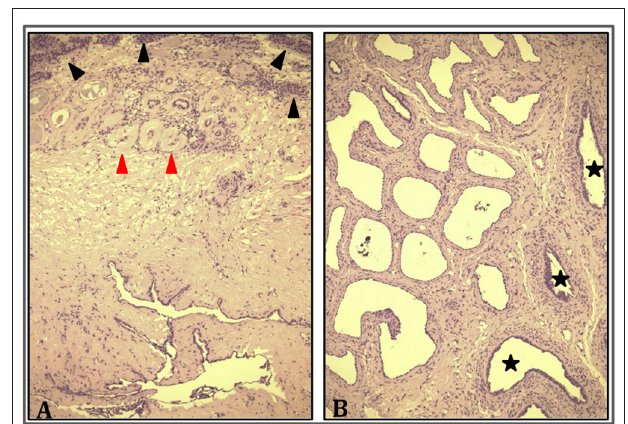
FIGURE 2 | Cystic dysplasia of rete testis. (A) Rete testis consisting of irregularly ectasic spaces lined by cuboidal epithelium and surrounded by fibrous stroma (bottom); testicular parenchyma (top) is characterized by prebuberal (black arrowhead) and atrophic seminiferous tubules (red arrowhead) (HE 10 × ). (B) Dilatation and irregularity of rete testis was global and reached the epididymis (black stars) (HE 20 ×